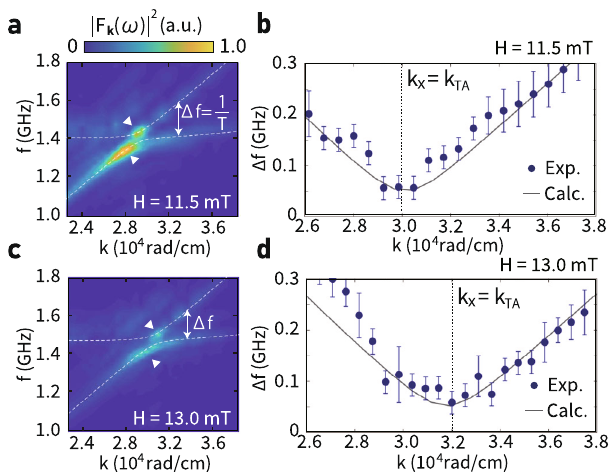
Fig. 3 Wavenumber and fi eld dependence of magnon-phonon coherent oscillation. a Frequency spectrum F k ( ω ) observed at B = 11.5 mT around the intersection of the magnon and transverse acoustic (TA) phonon dispersion curves. b Comparison between experimentally obtained gap between the upper branch and lower branch of the spectrum at B = 11.5 mT and the theoretical calculation of the gap frequency. Error bars represent standard deviation. c Frequency spectrum F k ( ω ) observed at B = 13.0 mT around the intersection of the magnon and TA-phonon dispersion curves. d Comparison between experimentally obtained gap between the upper branch and lower branch of the frequency spectrum at B = 13.0 mT and the theoretical calculation of the gap frequency.